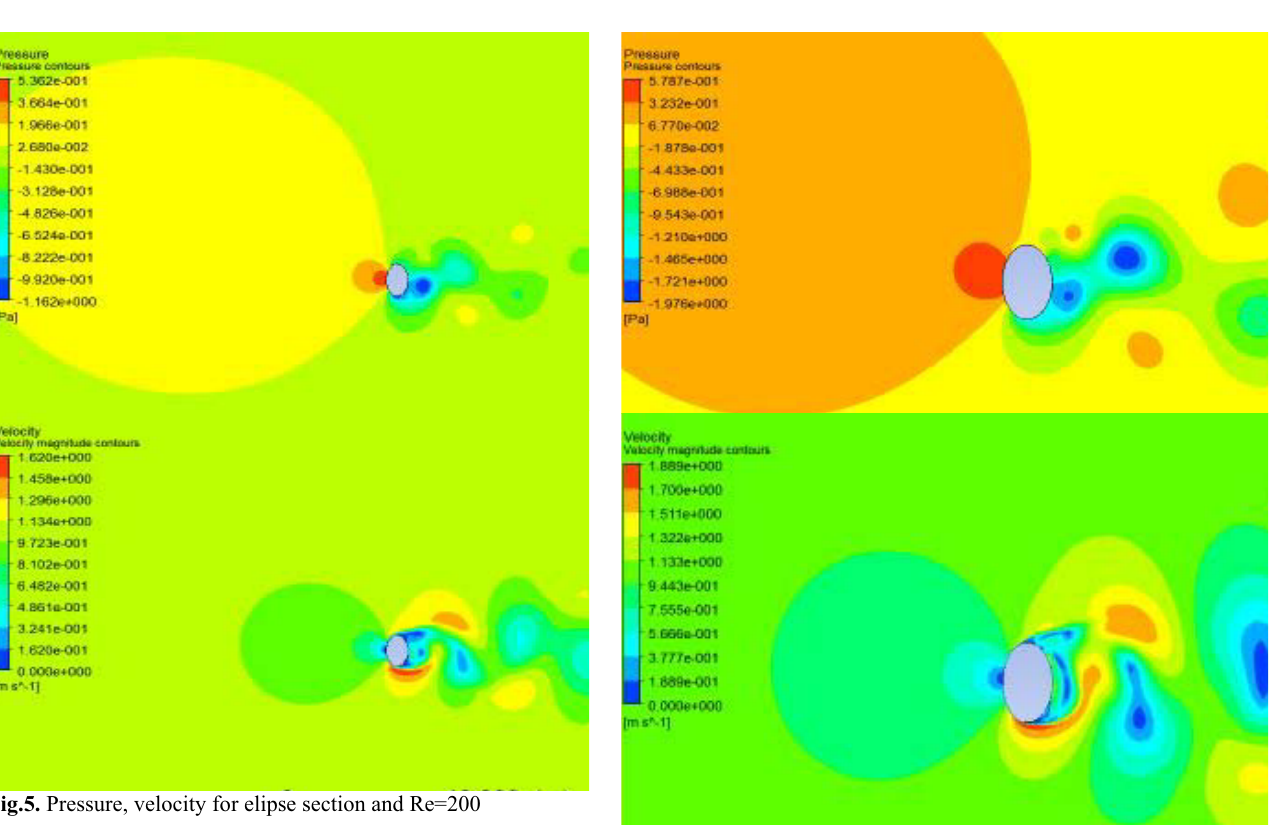
Fig.7. Pressure, velocity for elipse section and Re=25000 Figure 8 shows the results of calculations of drag and lift coefficients for various values of the Reynolds number and circle and ellipse cross-sections.